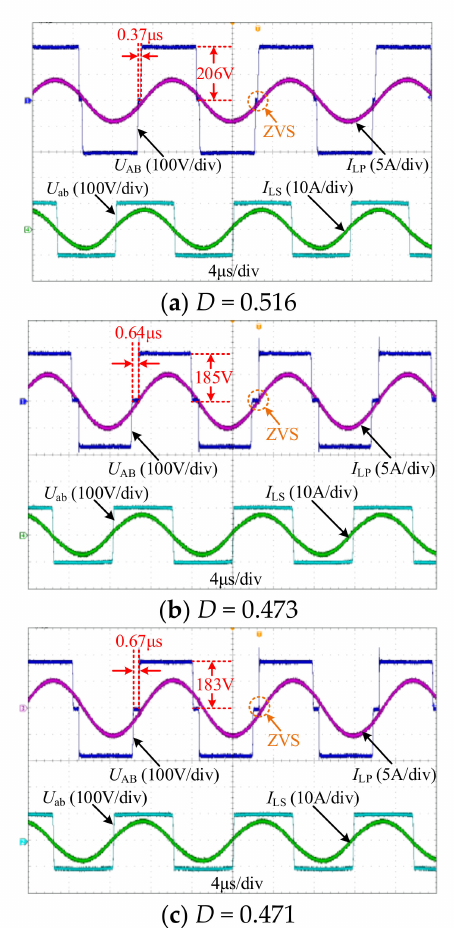
Figure 13. Experimental waveforms in different phase-shifted conditions. The power transfer efficiency (PTE) and output voltage curves according to the offset condition are given as shown in Figure 14.